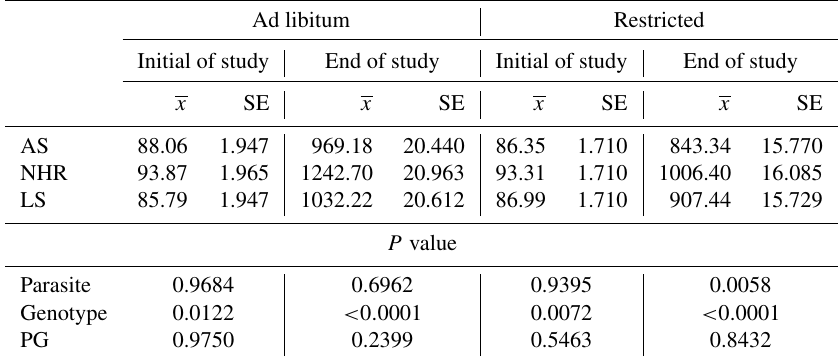
Table 1. Least square means ( x ) of live weights at the beginning and end of the study and their standard errors (SEs) and significance levels ( P ) under ad libitum and restricted-feeding conditions in infested (P + ) and non-infested (P − ) birds.